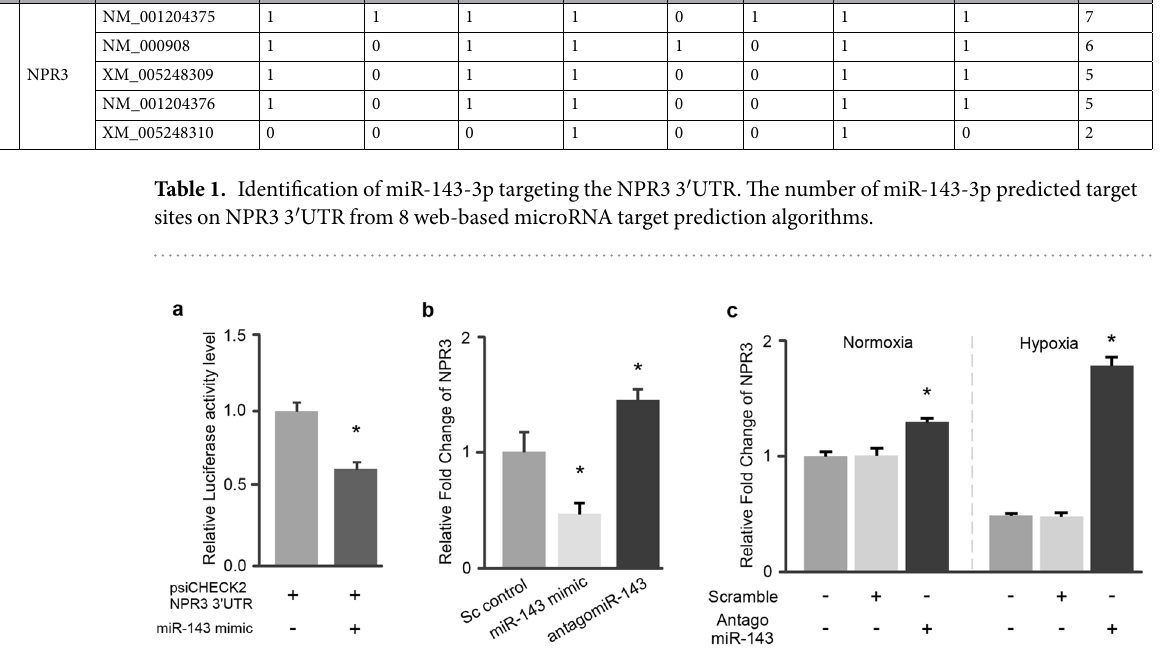
Figure 2. Regulatory effects of miR-143 on the expression of NPR3. ( a ) Luciferase reporter assay to demonstrate the interaction between miR-143 and NPR3 3 ′ UTR. ( b ) Overexpression of miR-143 (miR-143 mimic) suppressed the expression of NPR3 and knockdown of miR-143 (antagomiR-143) increased NPR3 transcripts level in HCMa. ( c ) NPR3 was upregulated in antagomiR-143 treated normoxic cells. Downregulation of NPR3 level in hypoxia-treated HCMa was reversed when co-treated with antagomiR-143. Data are presented as mean ± SD, n = 3, Student’s t test, * p <